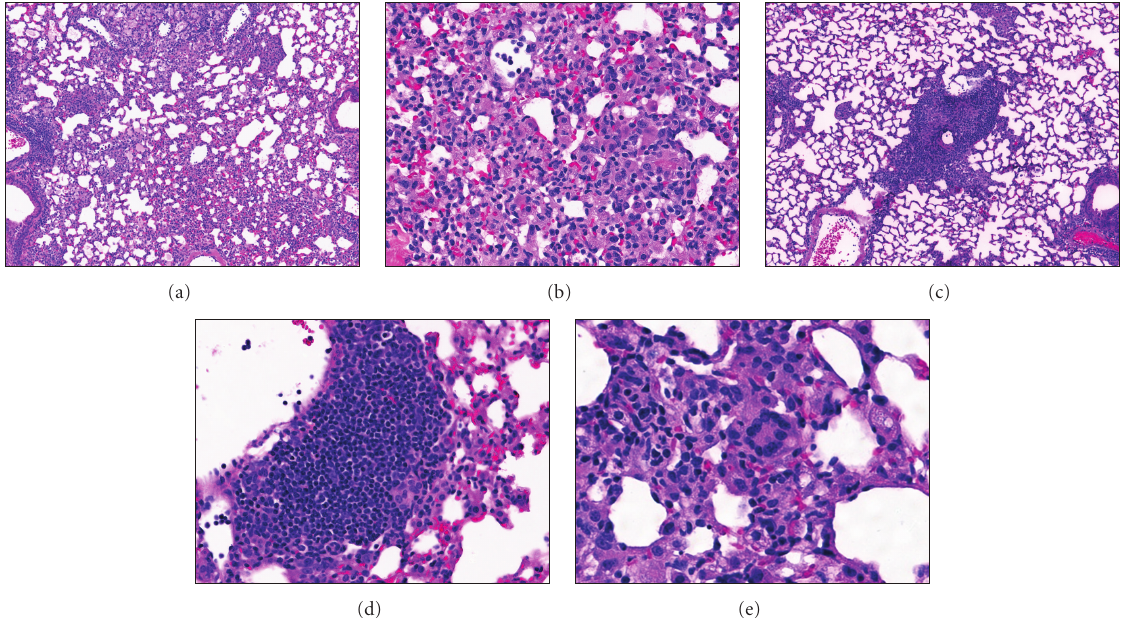
Figure 2: Lung histopathology of wild-type C57BL/6 and C7 − / − mice after the-challenge with MTB Erdman. (a) C57BL/6 mice demons- trate extensive granulomatous inflammation at 60 days post infection, 100x. (b) High power images of wild-type mice show that infiltrates are largely macrophages, 400x. (c) C7 − / − mice have reduced lung immunopathology at day 60 after the infection, 100x. (d) Abundant areas with clusters of lymphocytes are observed in C7 − / − mice, 400x. (e) Rare multinucleated giant cell in C7 − / − mice, 400x.